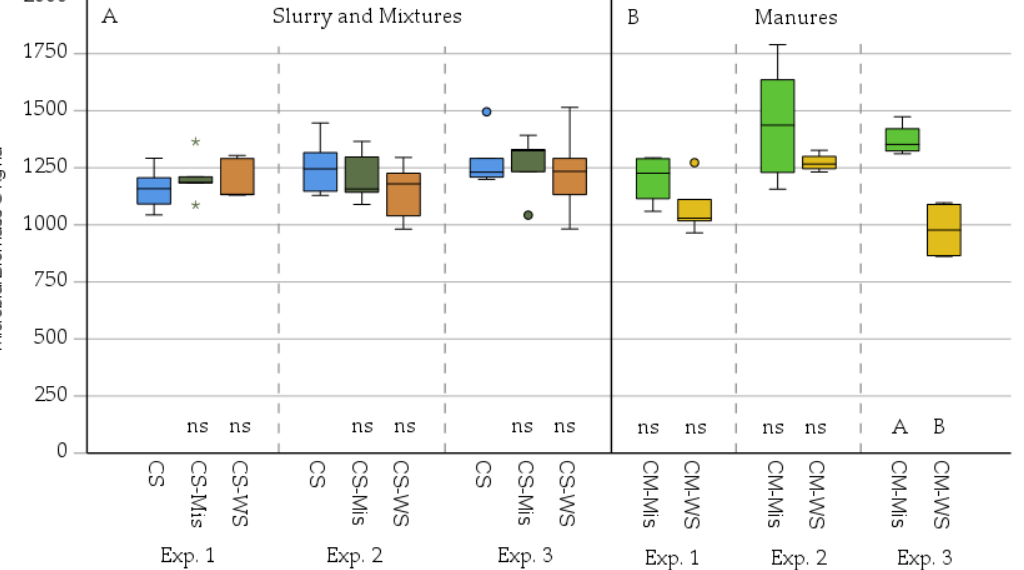
ha −1 ) and exp. 2 and 3 (170 kg total N ha −1 ) at the end of the experiment for each treatment ( A ): CS = Cattle Slurry, CS- Mis N ha − 1 ) and exp. 2 and 3 (170 kg total N ha − 1 ) at the end of the experiment for each treatment ( A ): CS = Cattle Slurry,